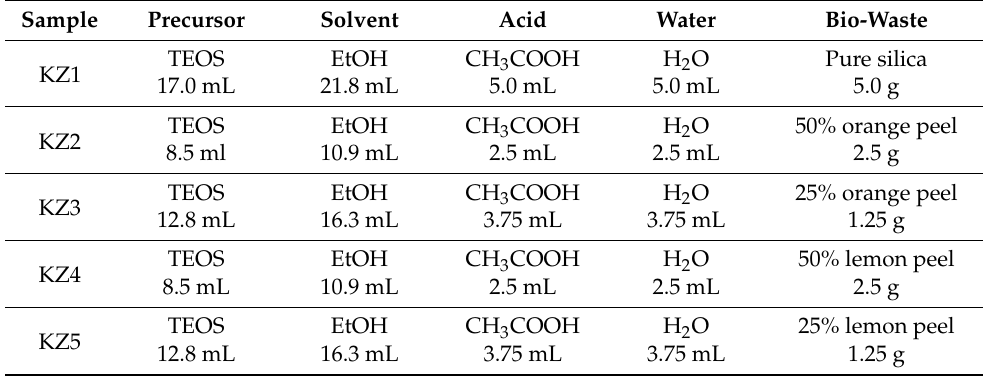
Table 1. Conditions employed in silica synthesis using acetic acid as a catalyst.